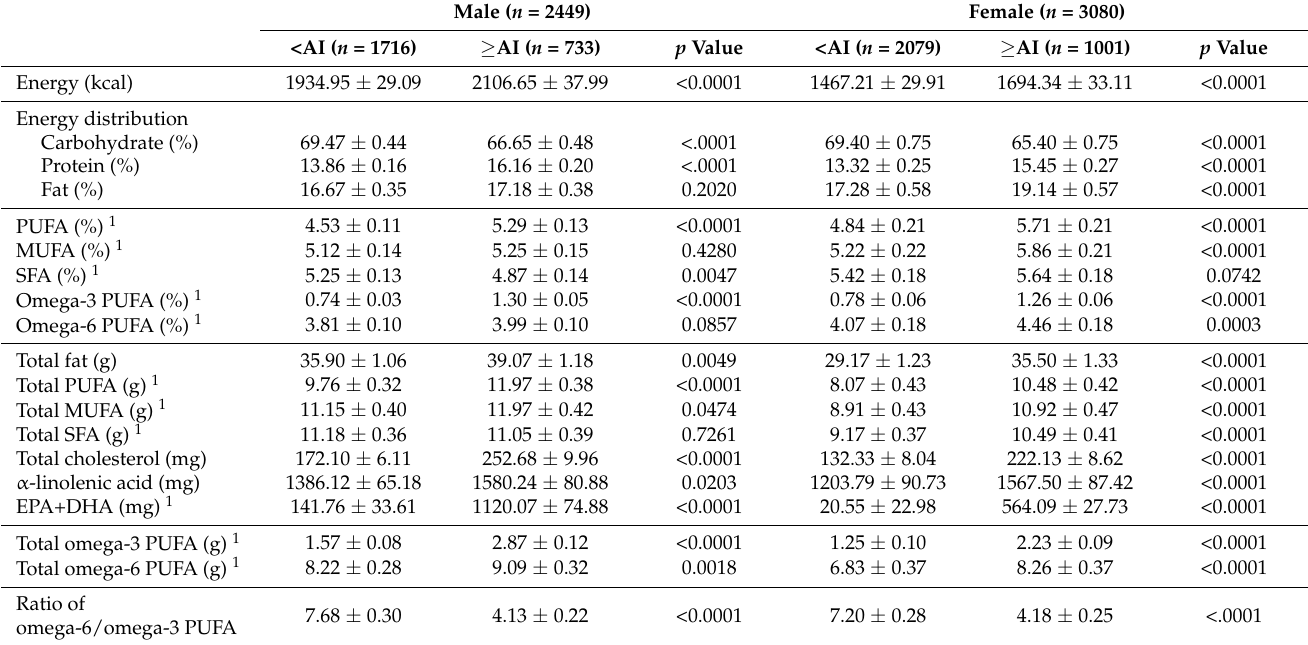
Table 2. Energy distribution and fat intakes of the study subjects according to EPA and DHA intake.